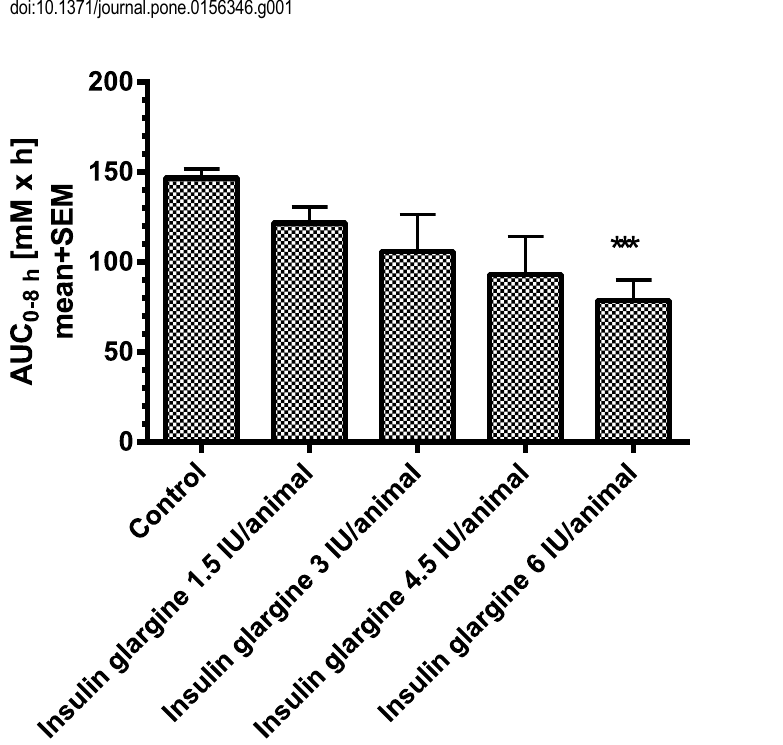
Fig 2. The calculated 8 h-blood glucose AUC (AUC 0-8h ) of STZ-rats (n = 5 per group). *** p < 0.001 vs. control.